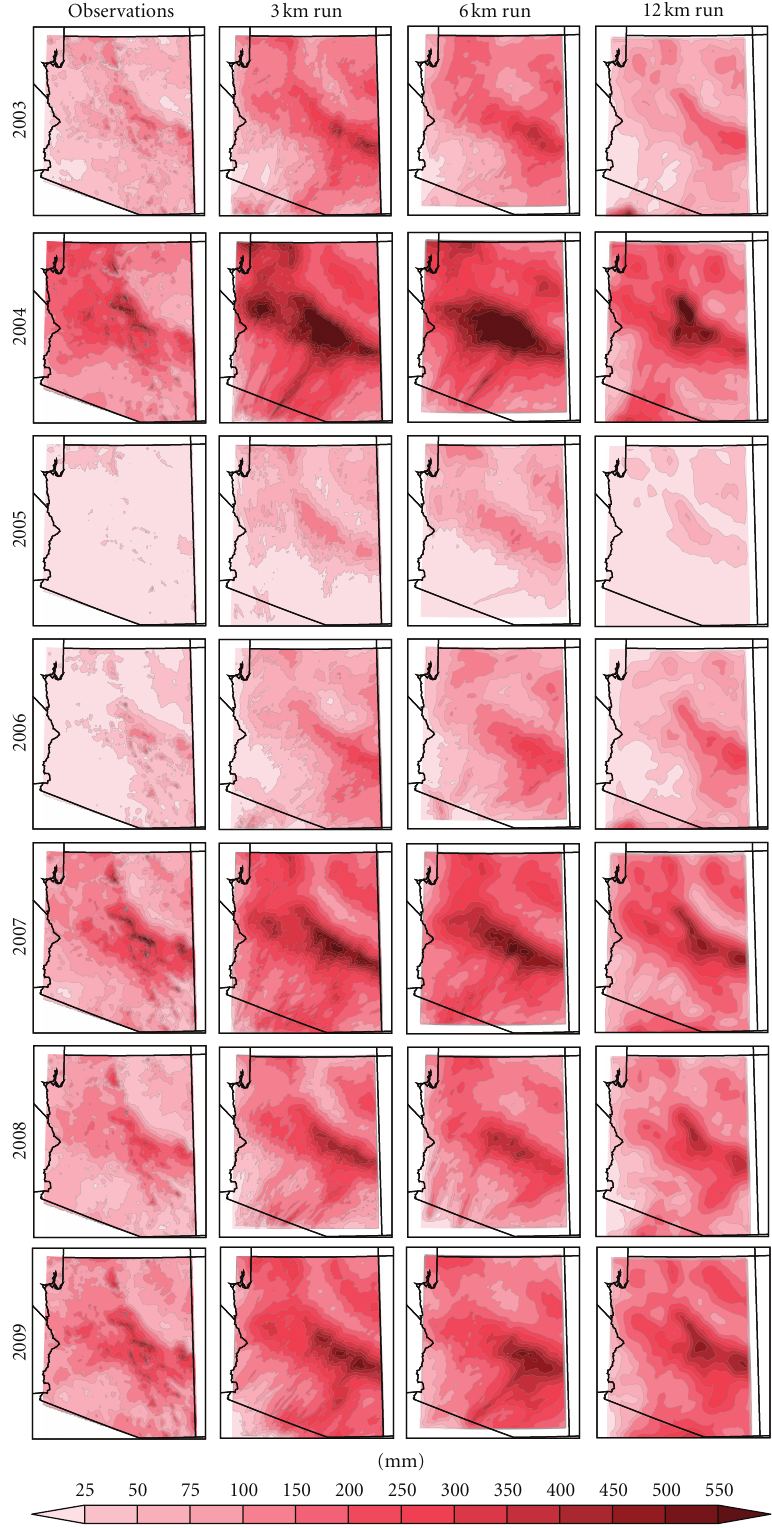
Figure 5: A year-by-year comparison of the simulated winter seasonal-mean rainfall with observation using the PRISM dataset. The 7 winters are arranged from top to bottom. The observation is shown at the leftmost column, followed to the right by the simulations with 3km, 6 km, and 12 km resolution. For brevity, for the 6 km runs only the case with cumulus convective scheme turned o ff is shown. The results for the case with convective scheme turned on are similar in pattern and